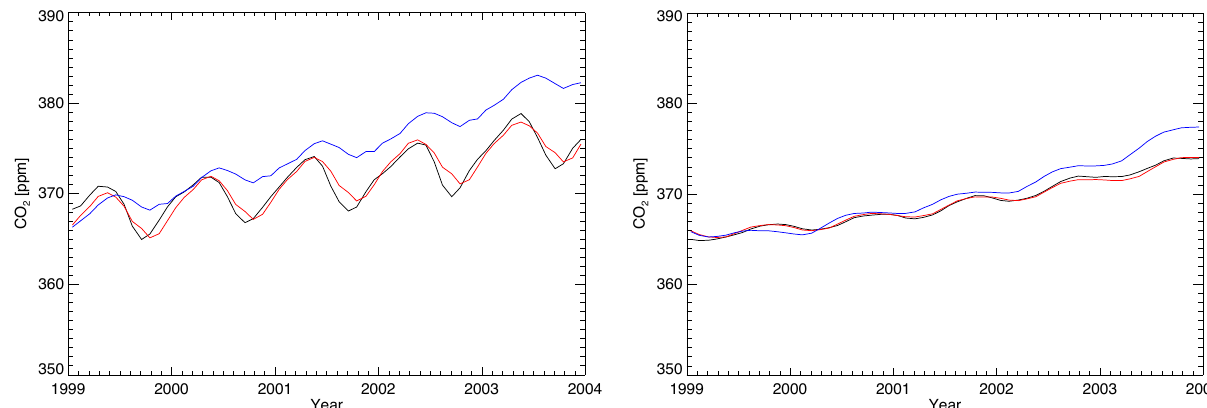
Fig. 2. Atmospheric CO 2 at Mauna Loa (left hand panel) and South Pole (right hand panel) in ppm: Observations (black), prior (blue), and posterior (red).